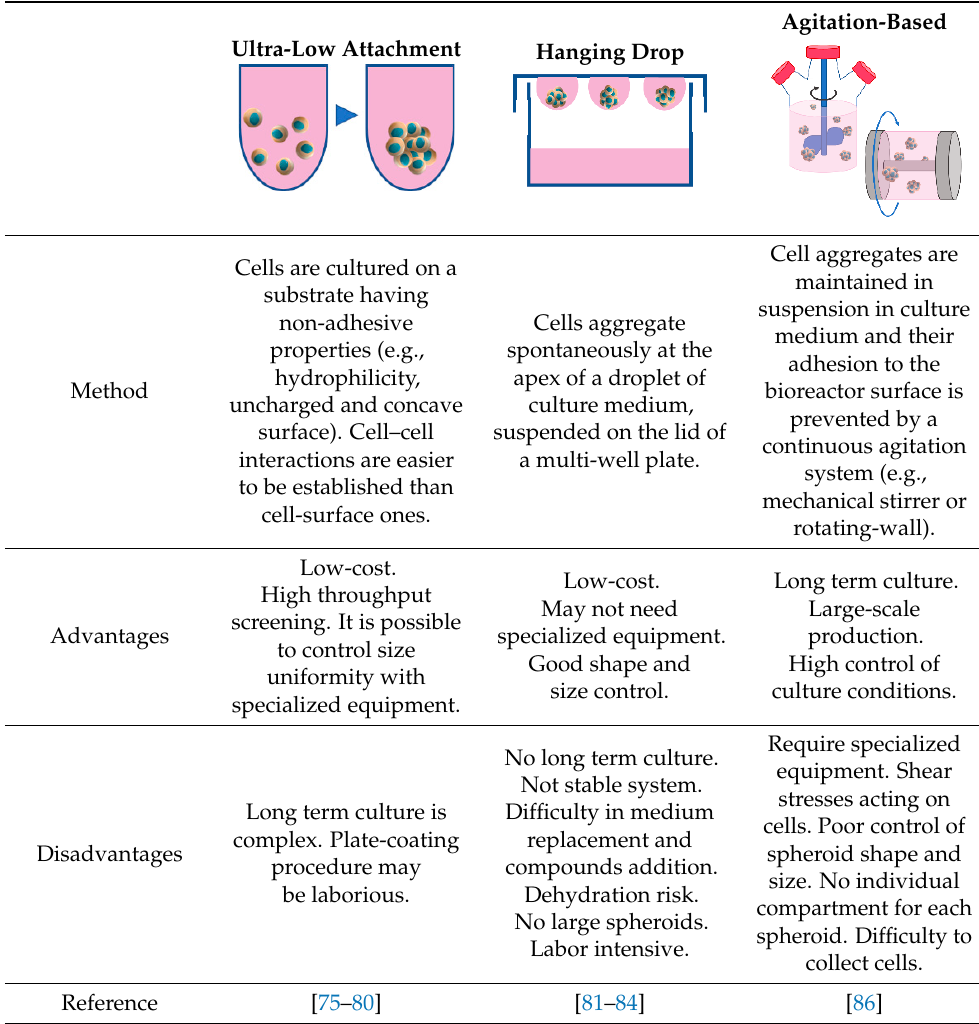
Table 2. Advantages and disadvantages of scaffold-free cell culture techniques.